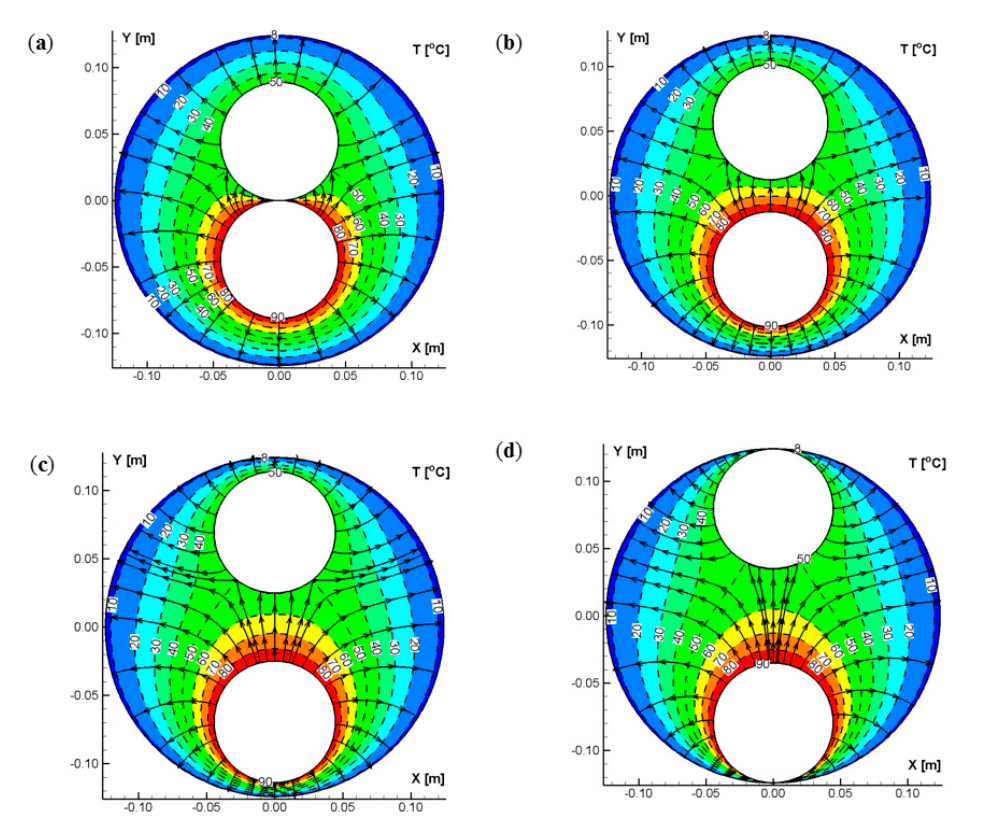
Figure 4. Temperature field and heatlines for ∆ T = 40 °C and selected distances between the supply and return pipes: ( a ) s = 0.01 mm, ( b ) s = 25 mm, ( c ) s = 50 mm, ( d ) s = 70